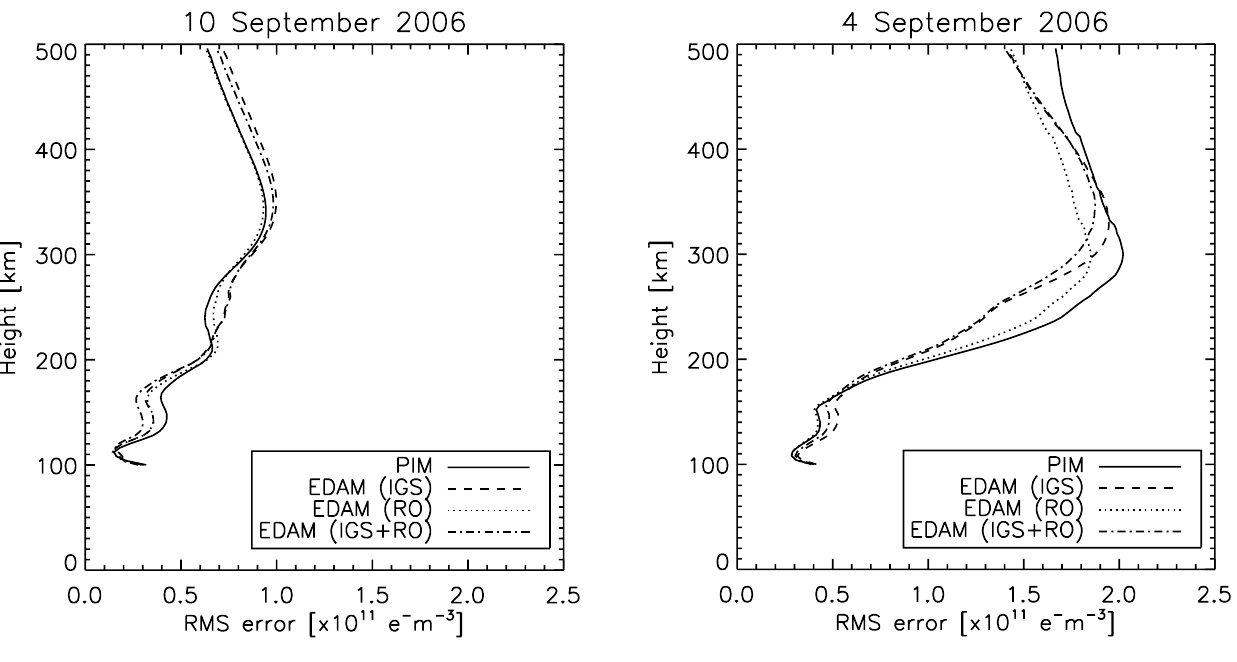
Fig. 4. RMS error between ionospheric models and ionosonde ver- tical profiles at 5km height steps on 10 September 2006 (quiet ge- omagnetic conditions). The models are: PIM (solid line); EDAM assimilating IGS data only (dashed line); EDAM assimilating COS- MIC RO data only (dotted line); and EDAM assimilating IGS and COSMIC RO data (dot-dash line).